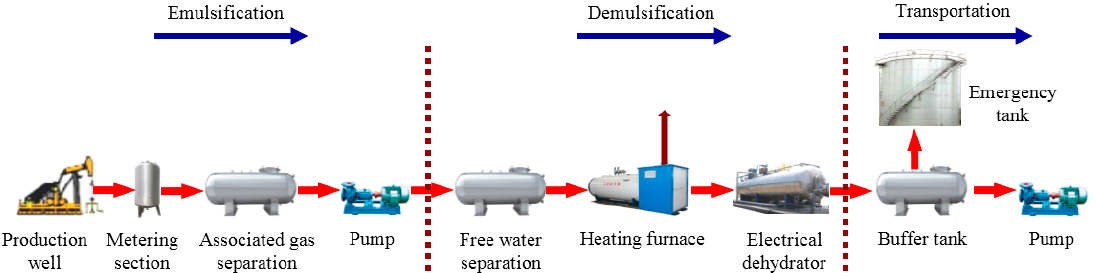
Figure 1. Illustration of the sources of agitation during oil production.